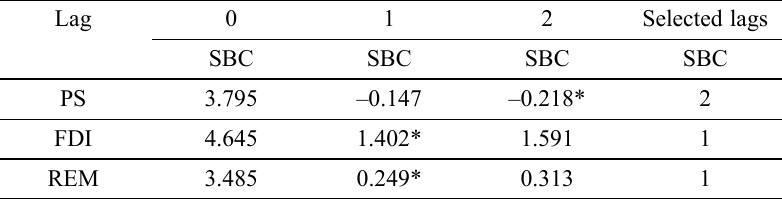
Table 4. Lags defined through VAR of variables